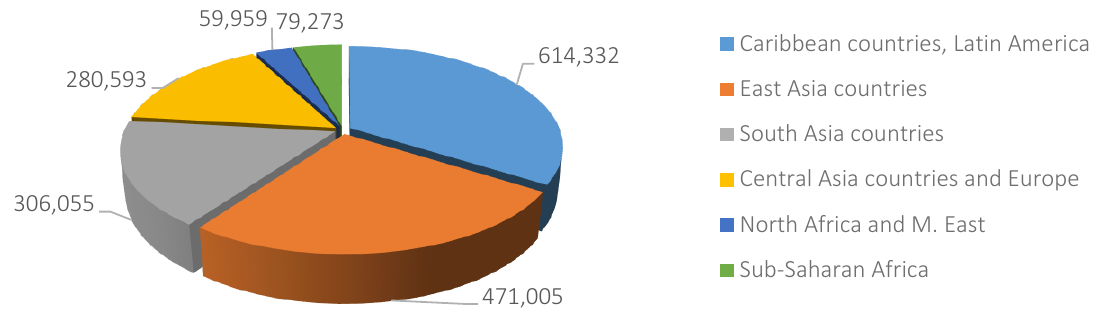
Figure 2. Regions, ranked by number of projects (1991–2019) (USD